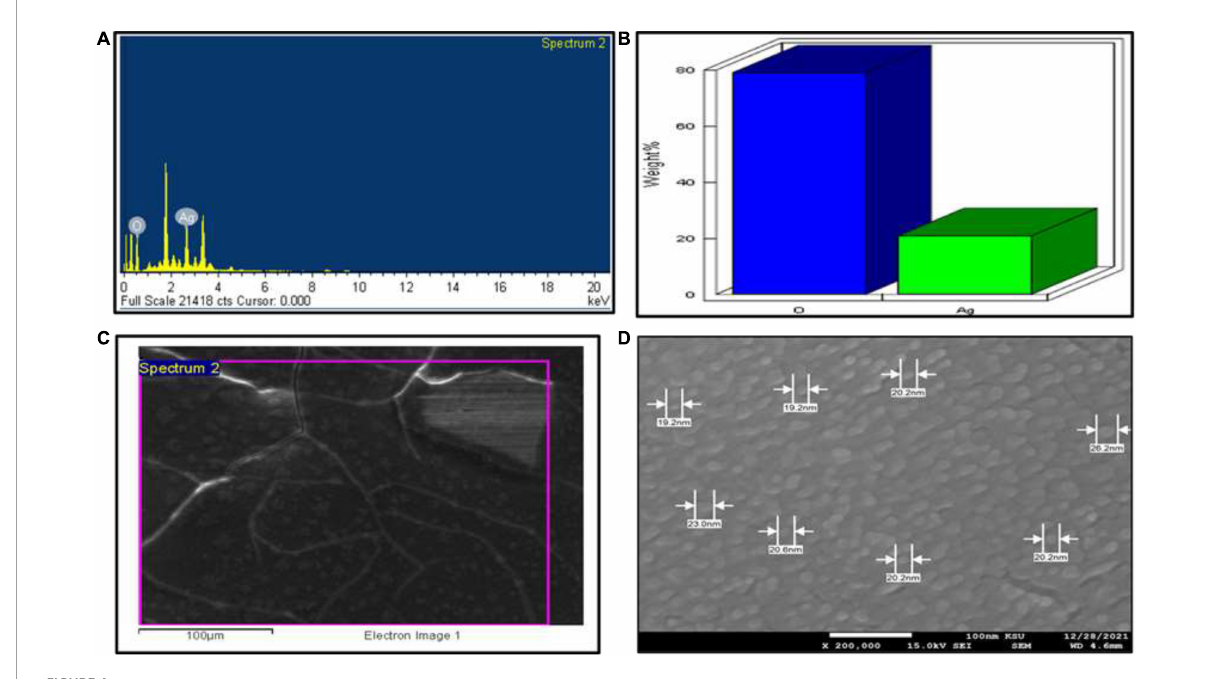
FIGURE4 SEM investigation. (A) EDX spectrum of biogenic AgNPs, (B) quantitative data analysis of images (weights of the oxygen and silver atoms), (C) distribution of silver in elemental mapping, and (D) shape and size of